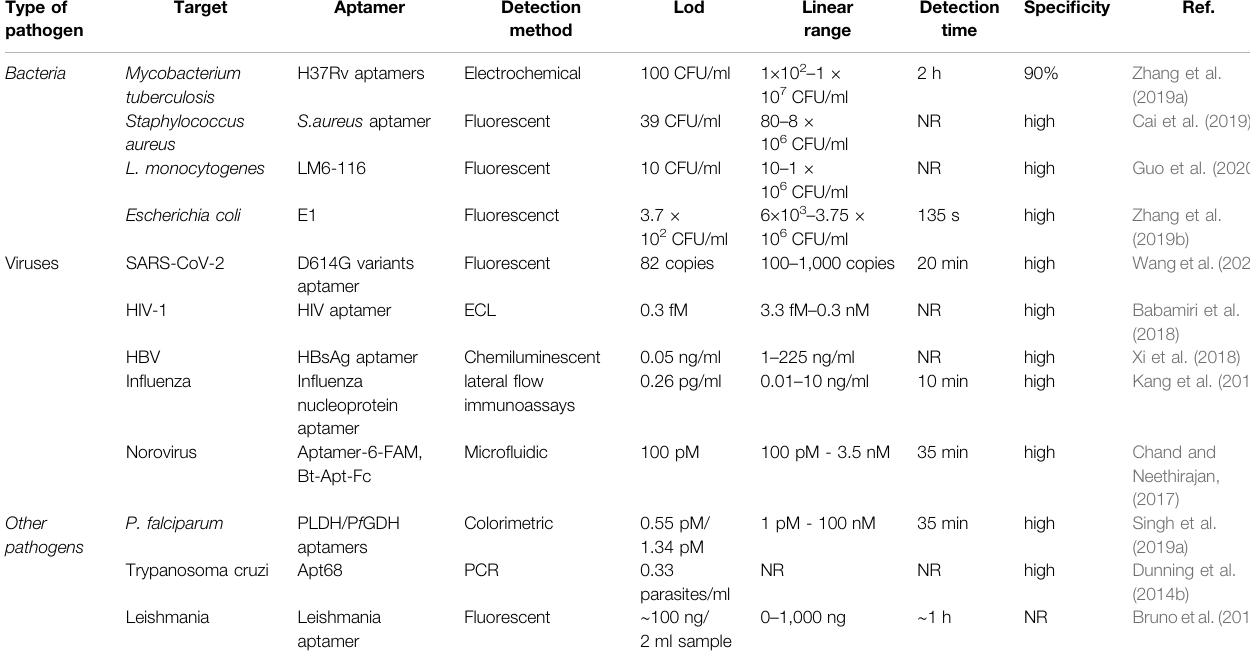
TABLE 3 | Comparison of aptasensor performance in the detection of various pathogen. Type of